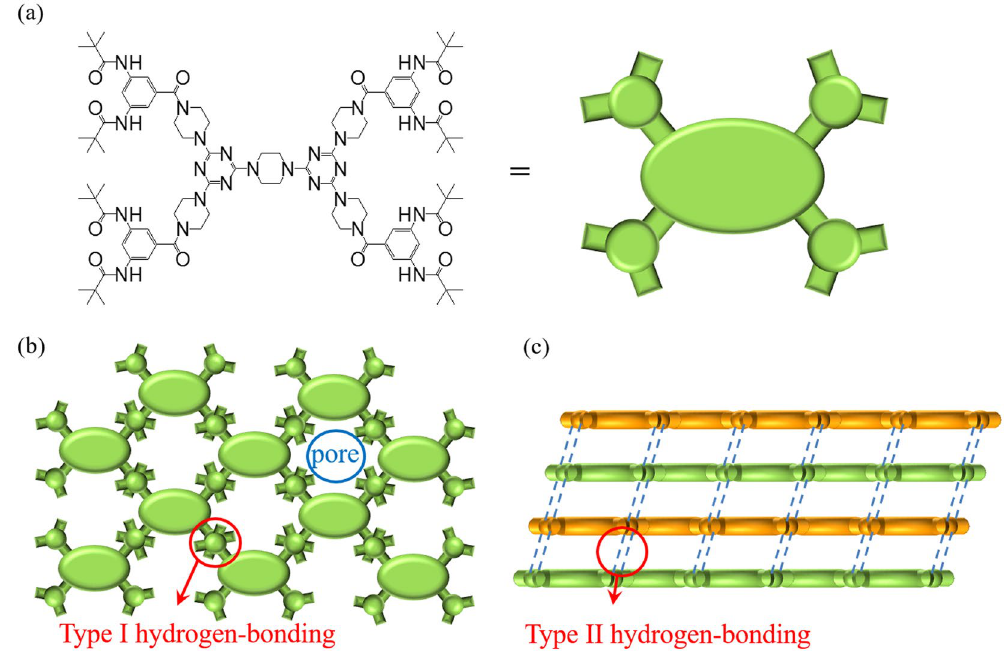
Figure 8. ( a ) ( t - Bu - G 1 N ) 2 as a supramolecular building unit with four branches, ( b ) the 2D network from ( t - Bu - G 1 N ) 2 units connected by H-bonds of type I, and ( c ) the 3D framework formed from 2D networks by H-bonds of type II. The scheme illustrates supramolecular connectivity of the units of ( t - Bu - G 1 N ) 2 in the solid state rather than the real 3D geometry of the dendrimer.